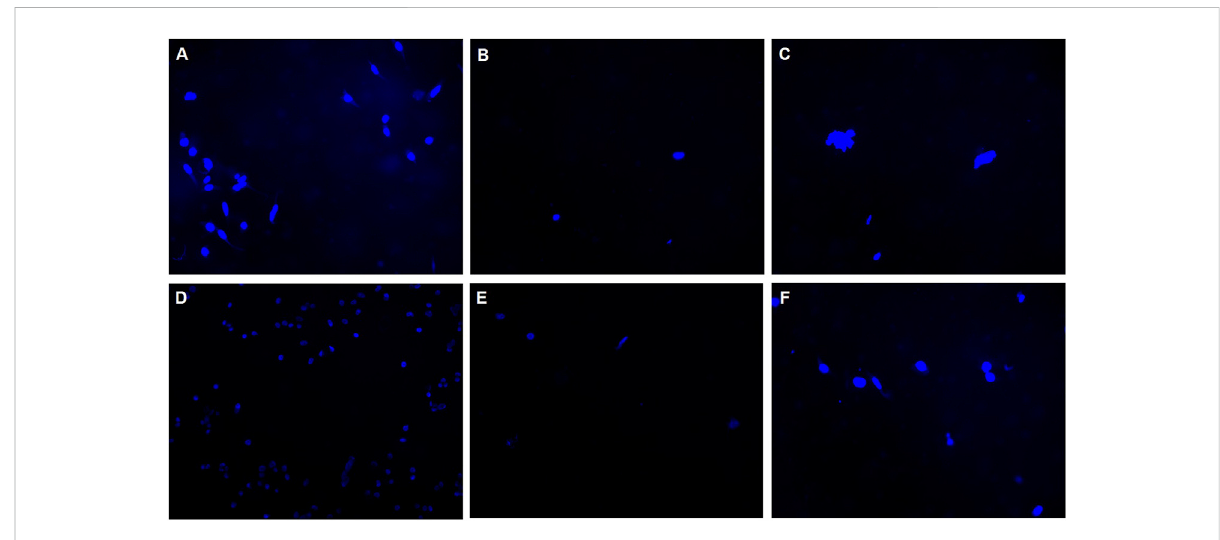
Silicone membranes cultured with CHO-K1 cells and stained with DAPI to investigate the cell attachment on the membrane. Images represent the distribution of cells attached on silicone membranes in (A) Day 1, (B) Day 2, (C) Day 3, (D) Day 4, (E) Day 7, and (F) Day 8.